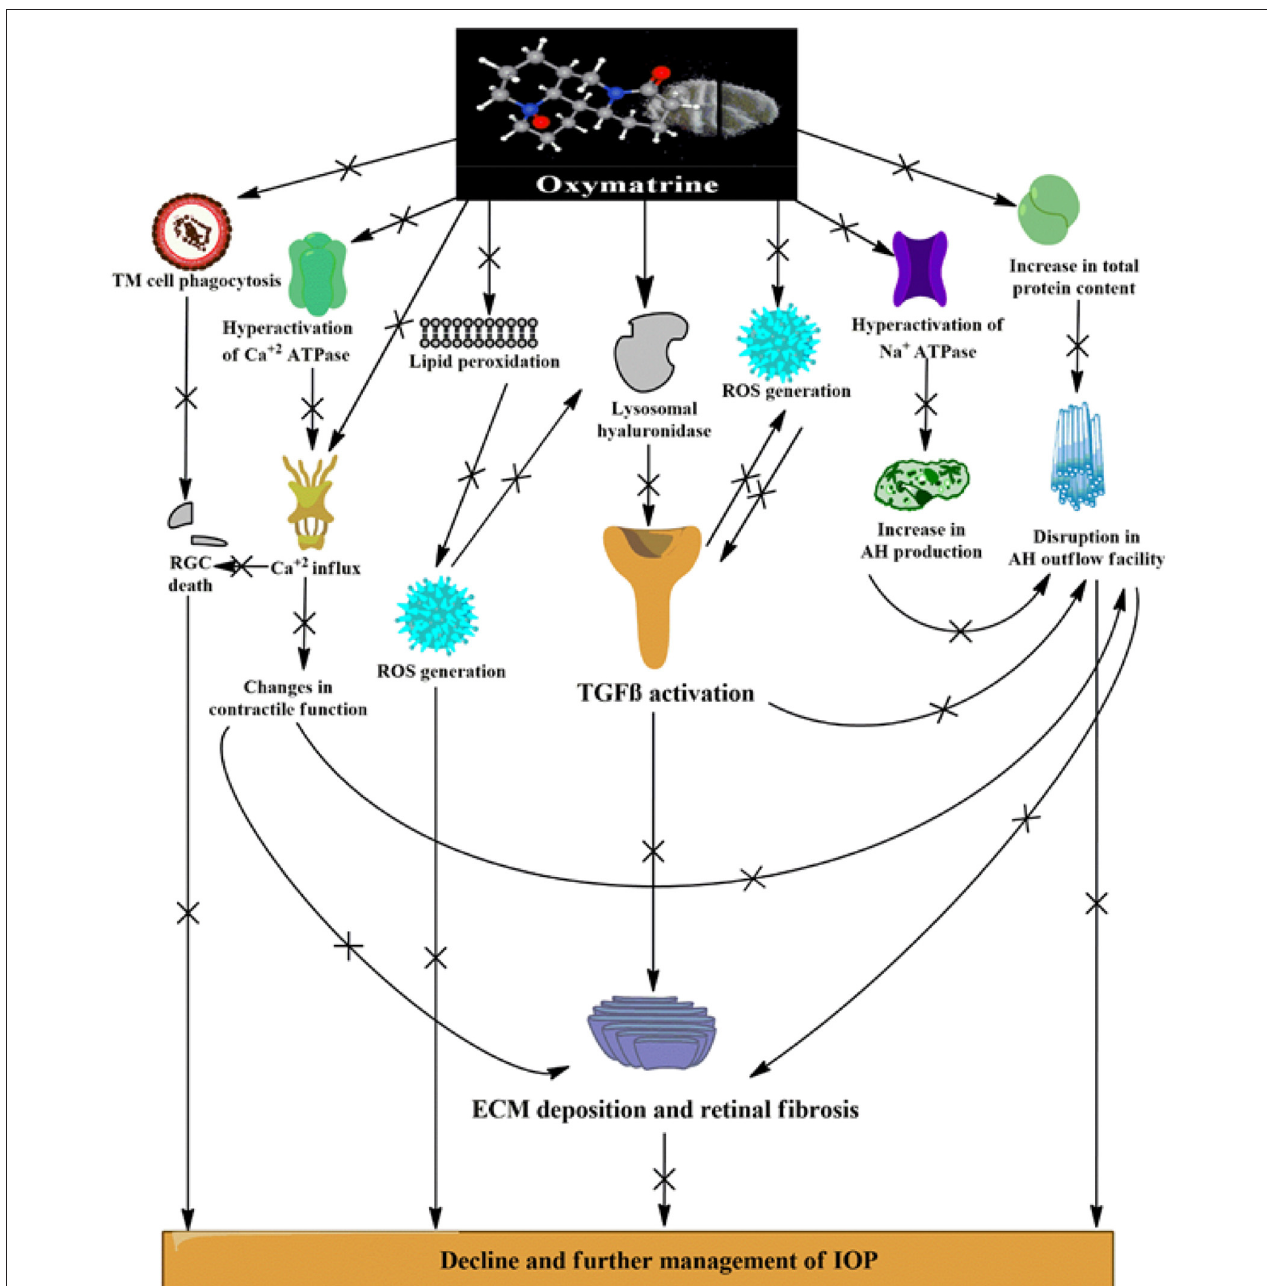
FIGURE 10 | Various possible targets served by OMT administration leading to effective management of IOP and mechanobiological alterations induced by DEX. [( + ) indicates activation or increase; (x) indicates inhibition or decrease]. ROS, reactive oxygen species; RGCs, retinal ganglion cells; AH, aqueous humor; IOP, intraocular pressure; TGF β -transforming growth factor β ; iNOS, inducible nitric oxide